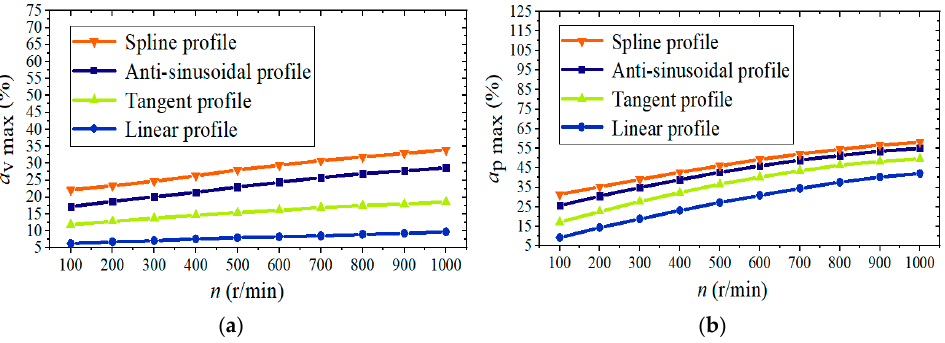
Figure 11. Relationship between maximum VVF and rotating speed. ( a ) Valve port maximum VVF; ( b ) pump chamber maximum